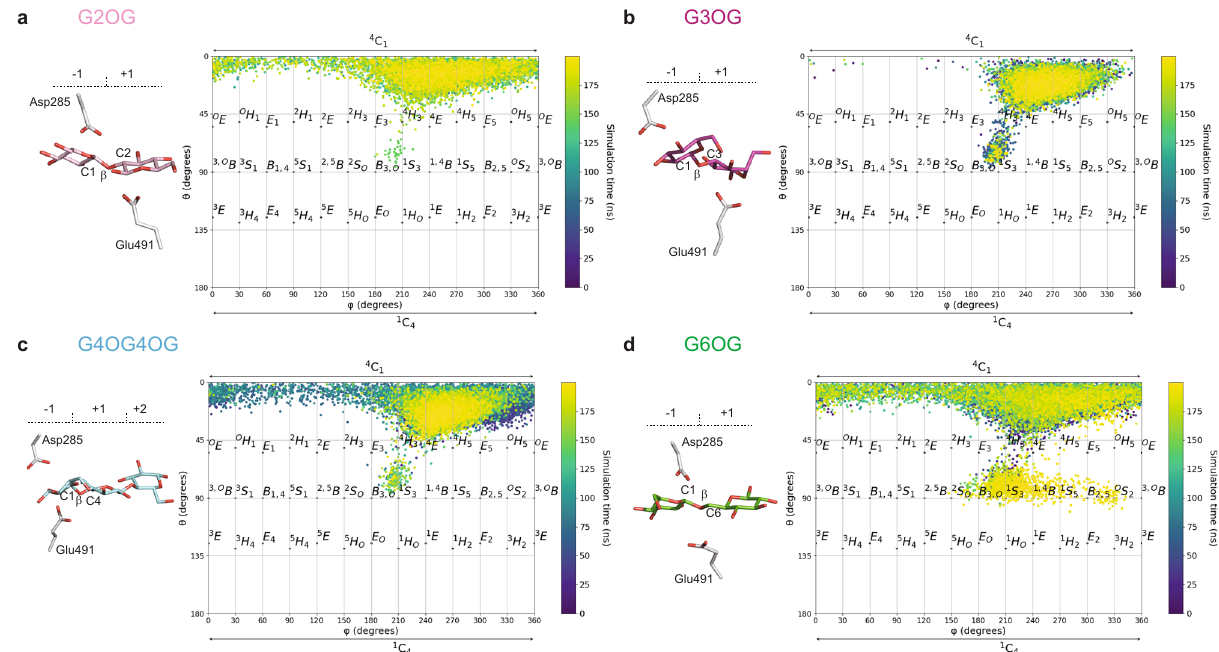
Fig. 5 | Conformational behaviour of O-linked oligosaccharides bound in the active site of HvExoI calculated by cMD simulations plotted as a function of θ and φ puckeringcoordinates.a Sophorose(G2OG;pink); b laminaribiose(G3OG; magenta); c cellotriose(G4OG4OG;cyan);and d gentiobiose(G6OG;green)ligands areboundatthe − 1to+2subsites(colourgradientsfrompurpleat0nstoyellowat